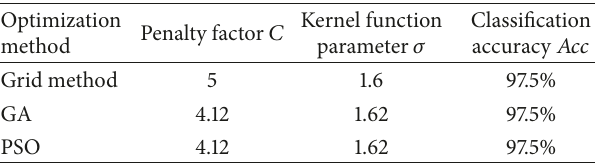
Table 2: Optimized parameters 𝐶 and 𝜎 and corresponding classi- fication